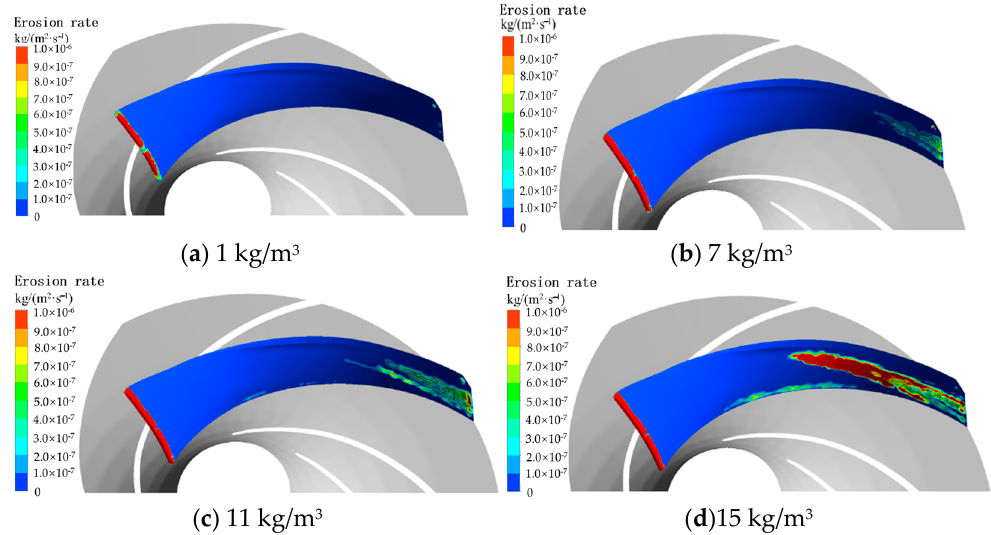
Figure 19. Erosion rate distribution of single blade with different particle concentrations.